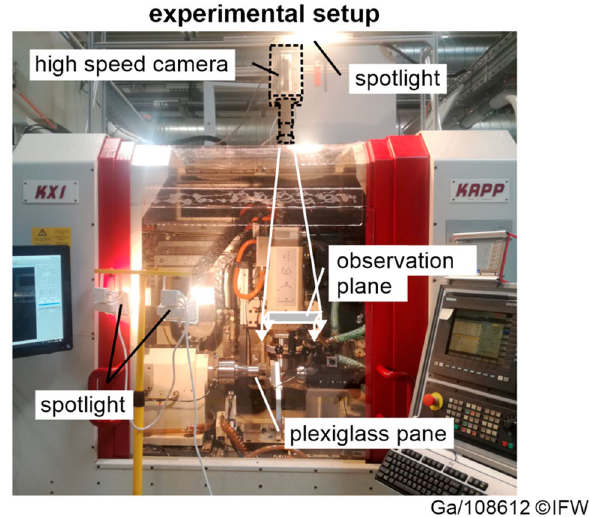
Fig. 4 Experimental setup for the development of the coolant velocity sensor